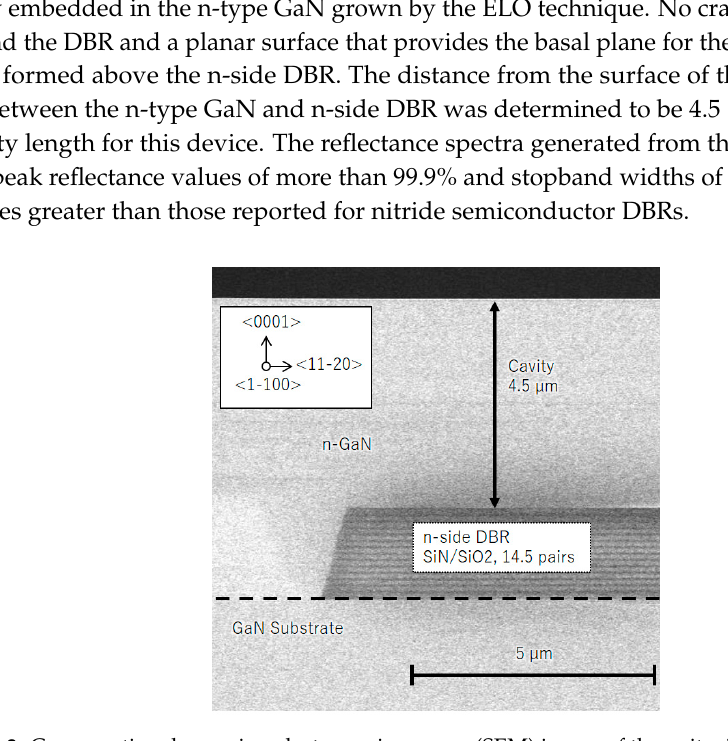
Figure 3. Cross-sectional scanning electron microscopy (SEM) image of the epitaxial lateral overgrowth (ELO) structure, in which the n-side DBR is engulfed in n-GaN grown using the ELO process. The flat surface of the epitaxial layer forms a 4.5-mm-long cavity.